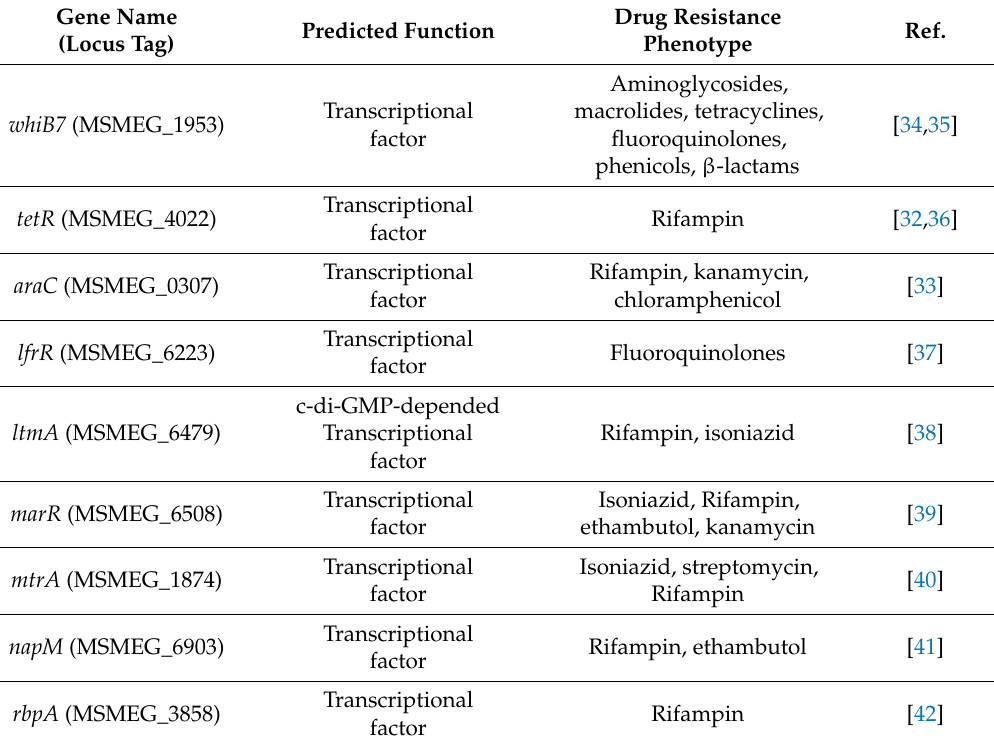
Table 3. Genes from M. smegmatis selected for study as they are involved in intrinsic drug